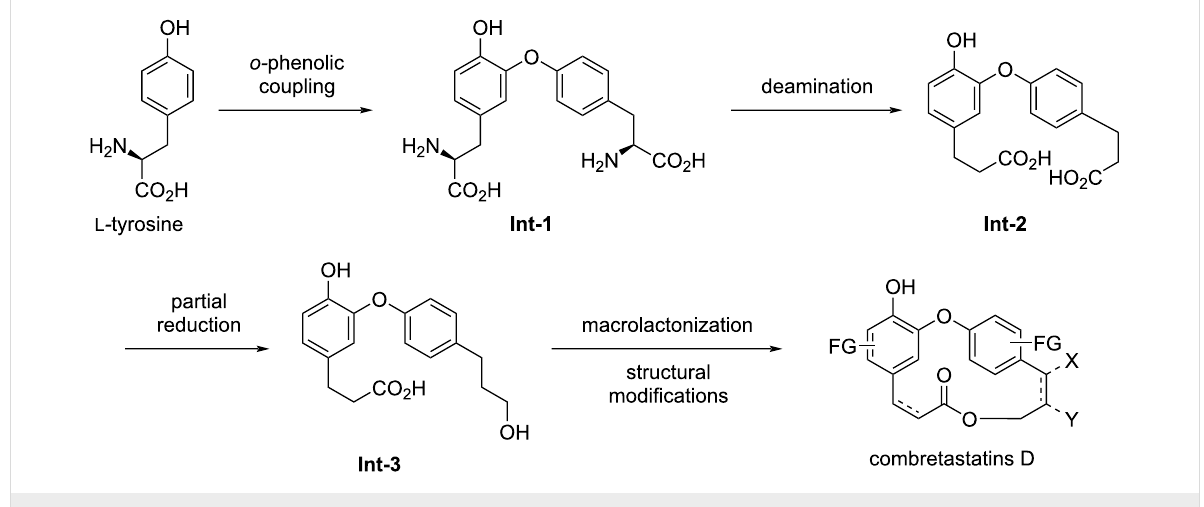
Scheme 1: Biosynthetic pathway proposed by Pettit and